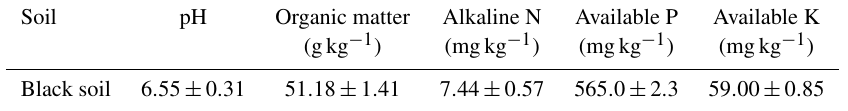
Table 1. Basic properties of the soil in field experiments. Note that values ( ± standard deviation) were averaged over three replicates. Soil pH Organic matter Alkaline N Available P Available K Black